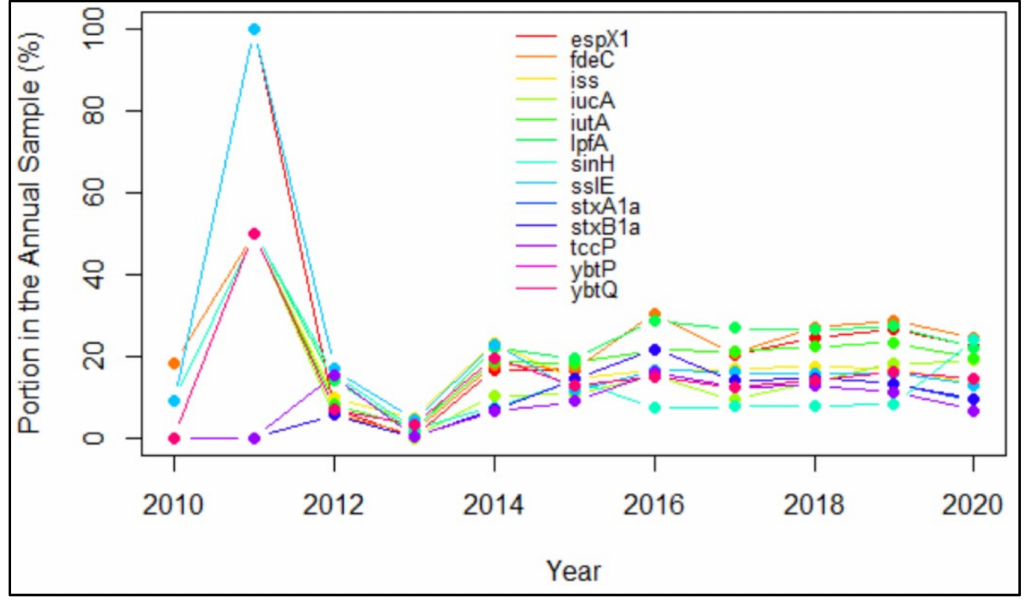
Figure 3. Normalized time profile of important virulence genes in the US with generally increasing prevalence in historic samples from 2010–2020.